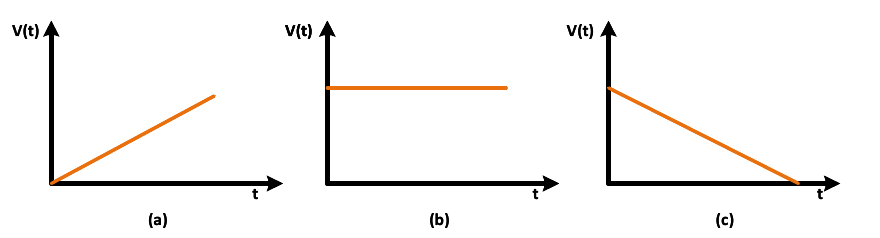
Figure 2. Synthetic speed profile construction: ( a ) Acceleration; ( b ) Cruising; ( c ) Deceleration . Table 3. Initial speed and acceleration ranges variation.